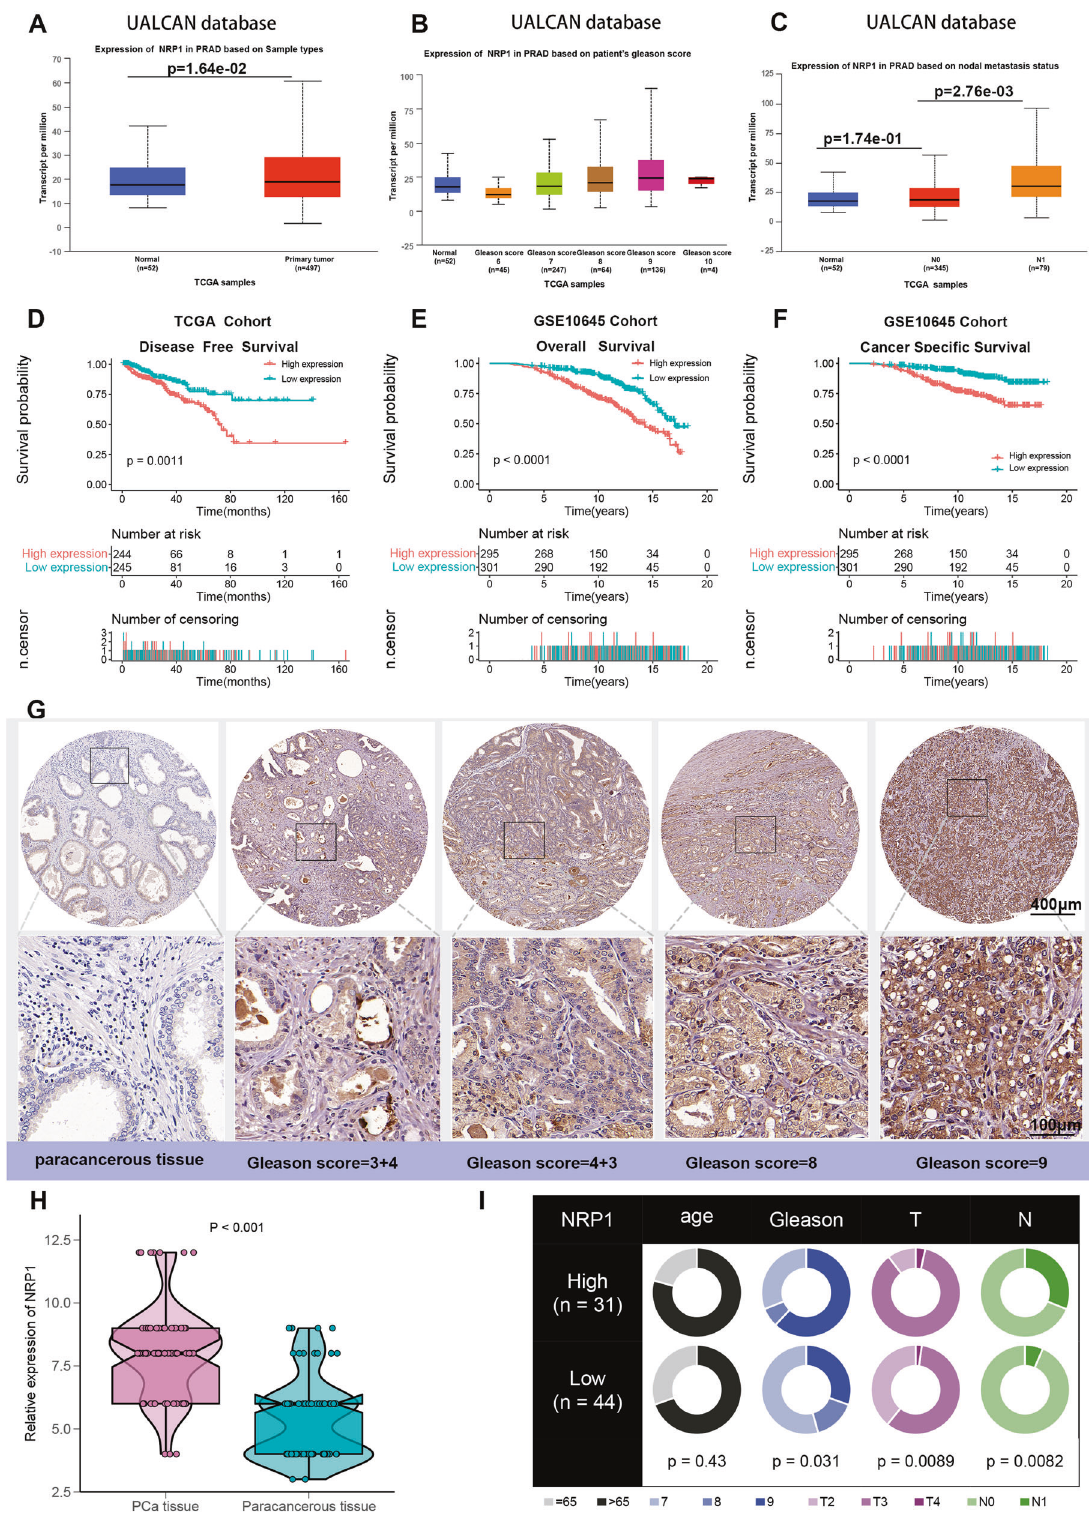
Fig. 1 NRP1 is overexpressed in PCa tissues and associated with unfavorable prognosis of PCa patients. A Differential expression of NRP1 gene in PCa and adjacent tissues. B NRP1 expression is associated with higher Gleason scores in PCa. C NRP1 expression is associated with lymphatic metastasis in PCa. A – C Complete data are obtained from the UALCAN database. D – F Kaplan – Meier survival analysis of PCa patients from the TCGA and GSE10645 datasets. G IHC analysis of NRP1 expression in 75 PCa samples. Representative images are shown, with the scale bar of 400 μ m and 100 μ m, respectively. H Differential expression of NRP1 protein in 75 PCa tissues and paired paracancerous tissues (statistical signi fi cance assessed using a Mann – Whitney U test). I Comparison of age, Gleason score, T stage, and N stage between high NRP1 expression group and low NRP1 expression group (grouping based on the median of IHC staining score, and statistical signi fi cance assessed using the chi-square test). Cell Death and Disease (2023)